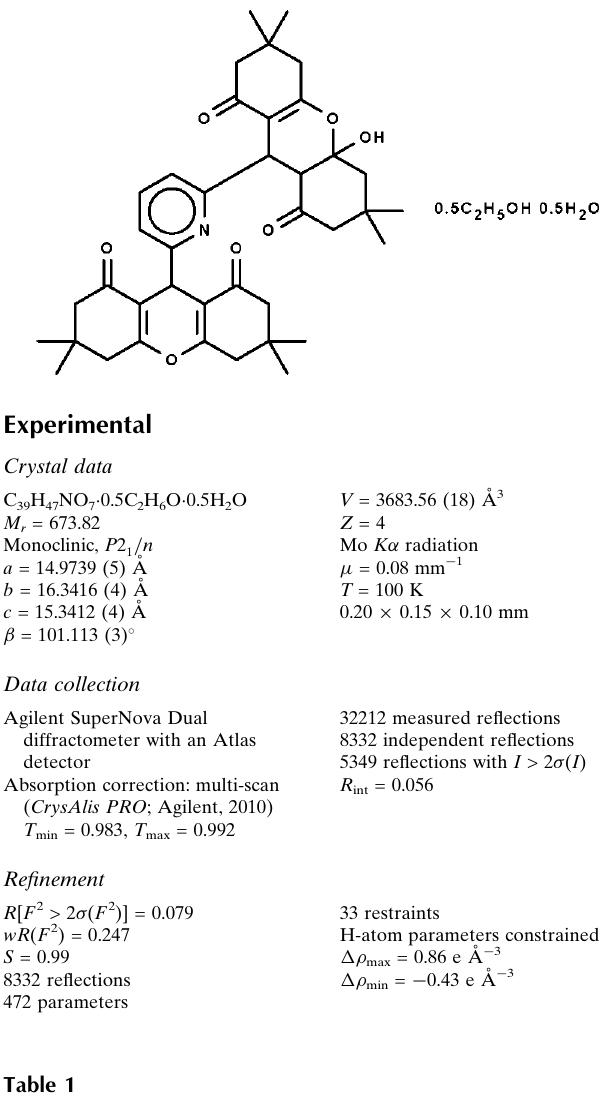
Hydrogen-bond geometry (A˚ , (cid:3)